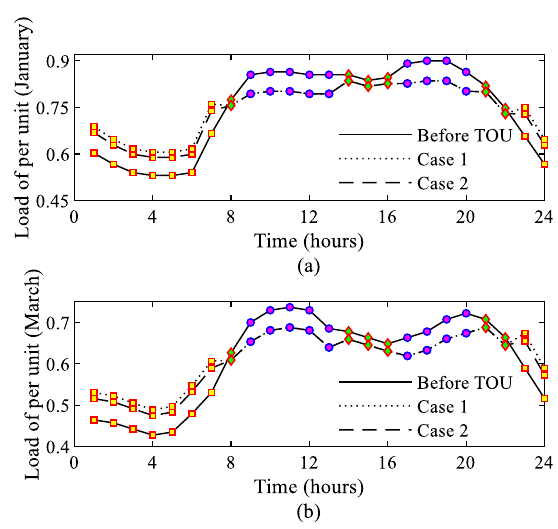
Fig. 8 Load curves before and after TOU price: a January; b March